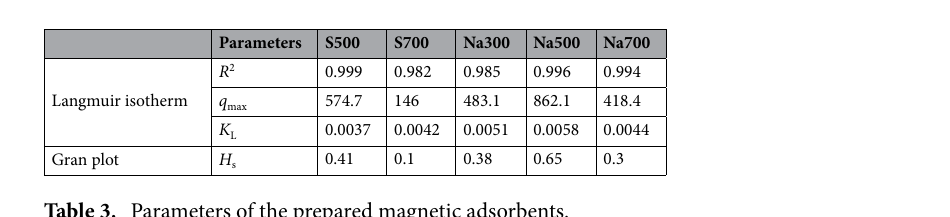
Table 3. Parameters of the prepared magnetic